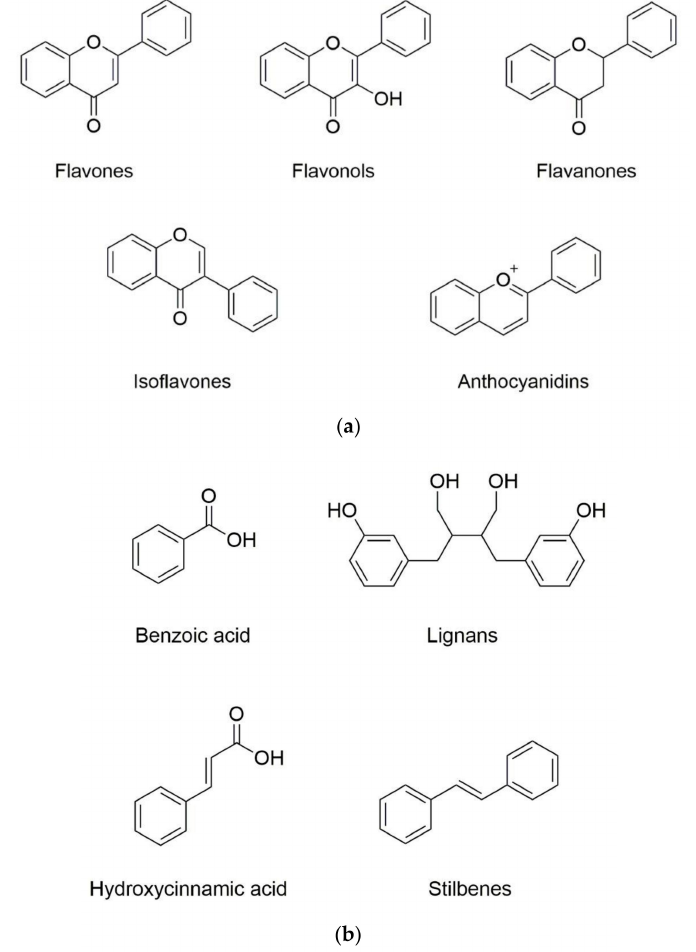
Figure 1. Basic structure of ( a ) common classes of flavonoids and ( b ) nonflavonoid-type phenolic